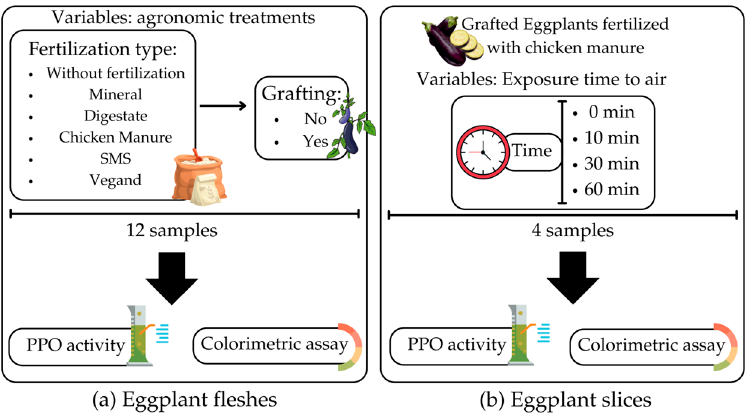
Figure 1. Experimental design and sample preparation methods in eggplant fleshes ( a ) and eggplant slices ( b ). PPO: polyphenol oxidase; SMS: spent mushroom compost.